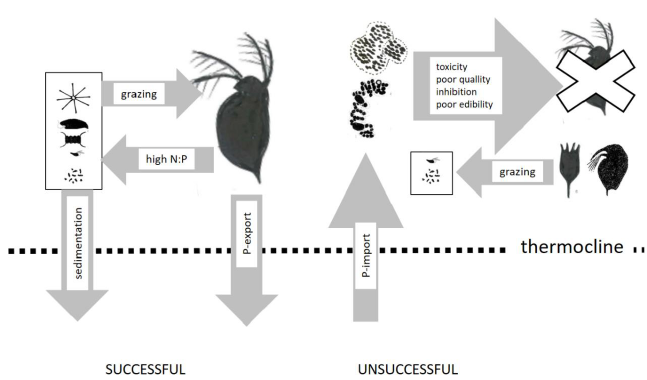
Figure 2. Idealized mechanisms stabilizing the successful and the unsuccessful state of bioman ipulation by removal of planktivorous fish. by removal of planktivorous